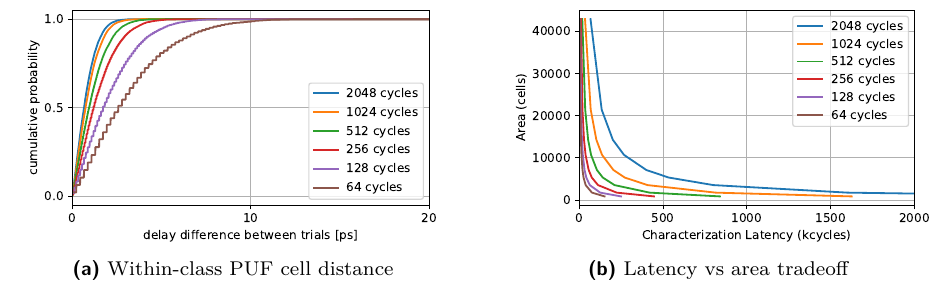
Figure 16: Design space